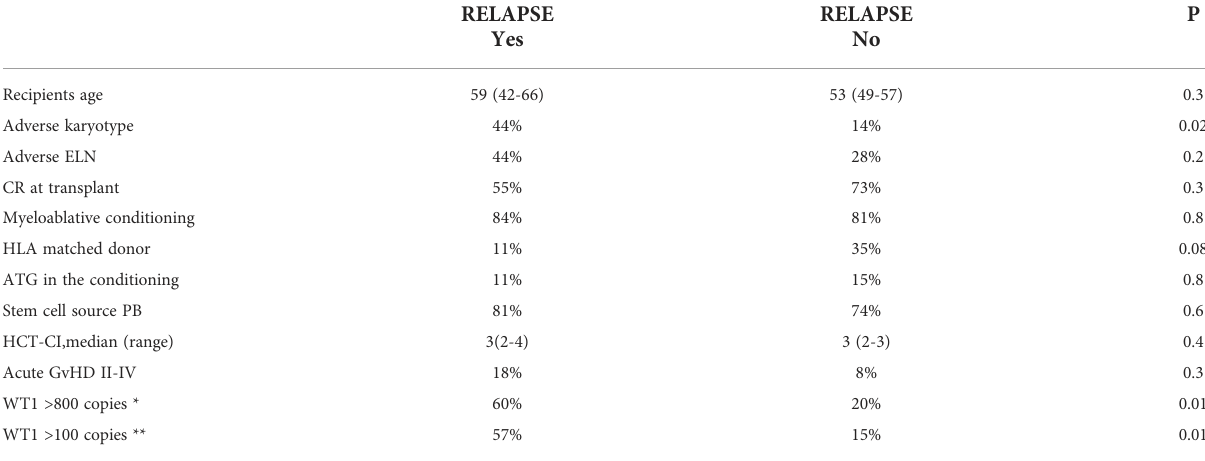
TABLE 2 Characteristics of patients who subsequently did or did not